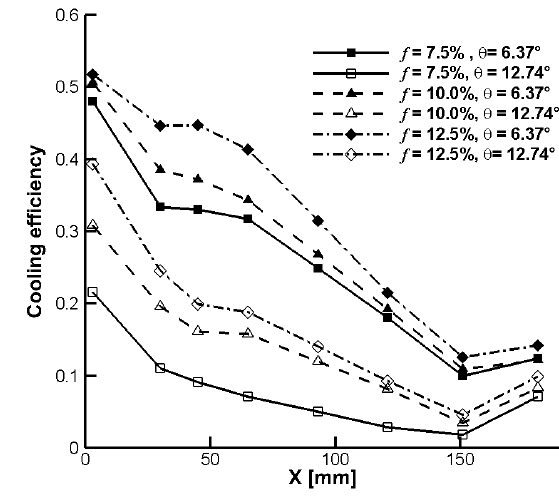
Figure 8. Average cooling efficiency along the axial direction.